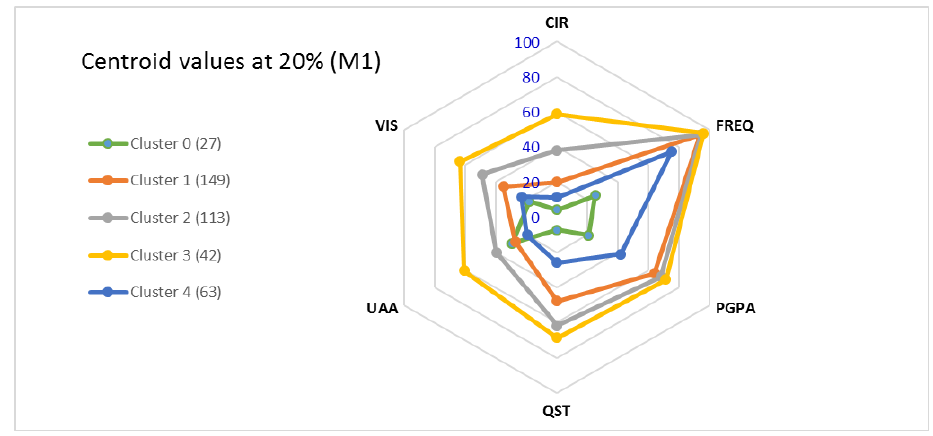
Figure 7. Clustering at M1.